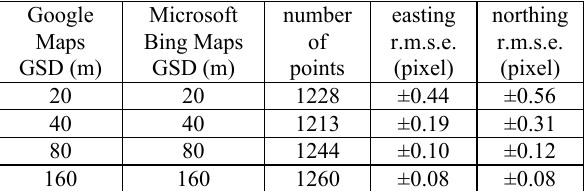
Table 2. Precision of relative registration of screen shots (covering Äußeres Hochebenkar rock glacier) of Google Maps and Microsoft Bing Maps applying simple translation